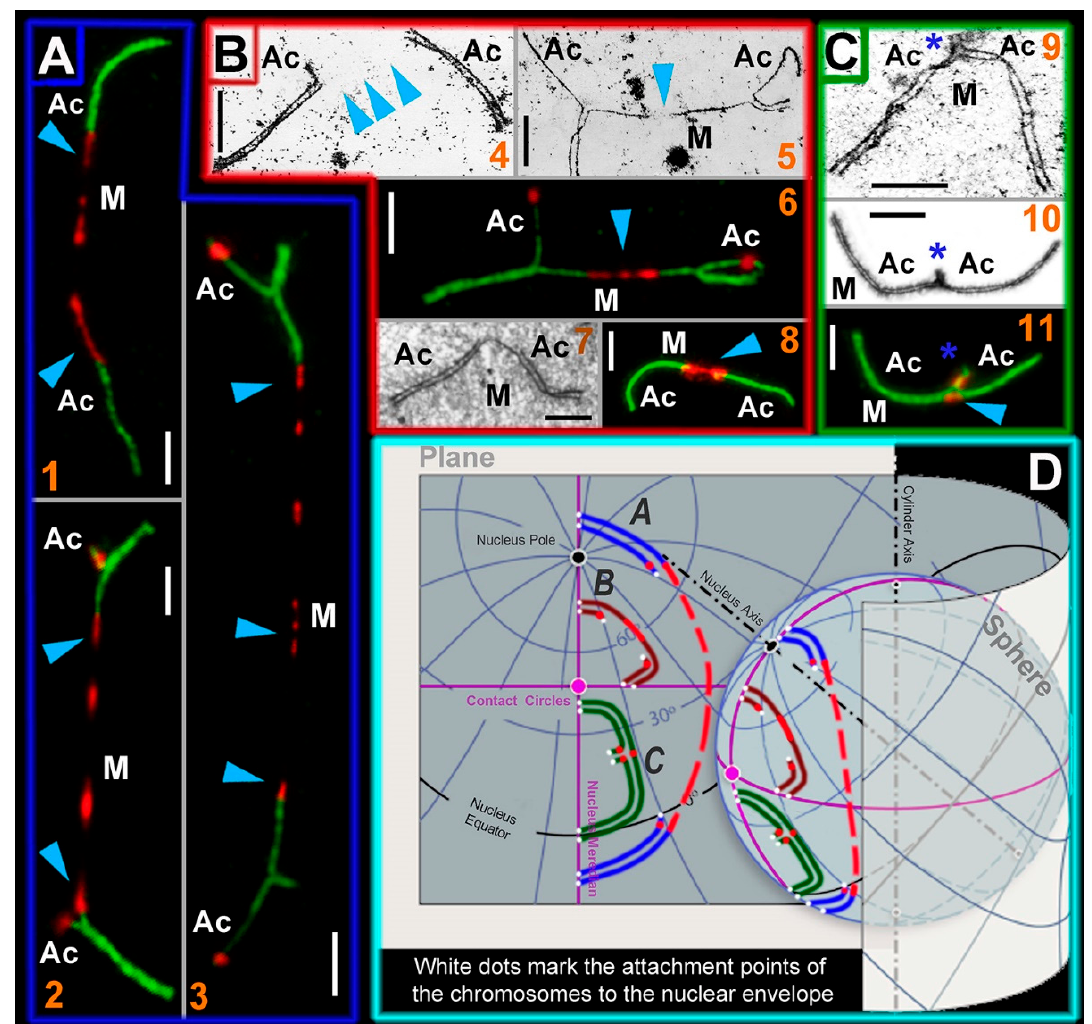
Figure 4. SC trivalent types of the Ellobius hybrids and their simulated location on a plane and a sphere. Light micrographs after immunostaining (1, 2, 3, 6, 8, and 11): SCs were immunostained with antibodies against SYCP3 (green) and centromeres—with an antibody to kinetochores (CREST, red). Electron micrographs after AgNO 3 -staining (4, 5, 7, 9, and 10): blue arrowheads show centromeric regions of metacentrics in SC trivalents. M indicates metacentric and Ac indicates acrocentric. ( A ) SC trivalents elongated by centromeric region stretching in spermatocytes of the E talpinus × E tancrei interspecific hybrid. The length of the centromeric region of metacentrics in such SC trivalents is > 3 µ m. (1) SC trivalents in which short arms were not visible: if there were no immunostained centromeric regions, then the SC trivalents would be identified as two pseudobivalents. (2) SC trivalents with short arms of acrocentrics. (3) SC trivalents with very stretched centromere. As a rule, such SC trivalents stretch across the length of the entire nucleus (from one side to the other). ( B ) SC trivalents with short stretched centromeric regions ( < 3 µ m in length). This type of SC trivalent was found in all hybrids. (4) Two pseudobivalents that are part of the SC trivalent. (5) The metacentric in the SC trivalent has a gap, in which there is probably a stretched centromeric region. (6) SC trivalents like in 5; the stretched centromeres of the metacentric are visible. (7 and 8) Short SC trivalents with faintly distinguished short arms of acrocentrics and not very stretched centromeres. ( C ) Closed SC trivalents with clearly visible short arms of acrocentrics (blue stars) and dot-like centromeres (9–11): This type of SC trivalent is found in all hybrids. ( D ) Simulation of SC trivalents on a plane and a